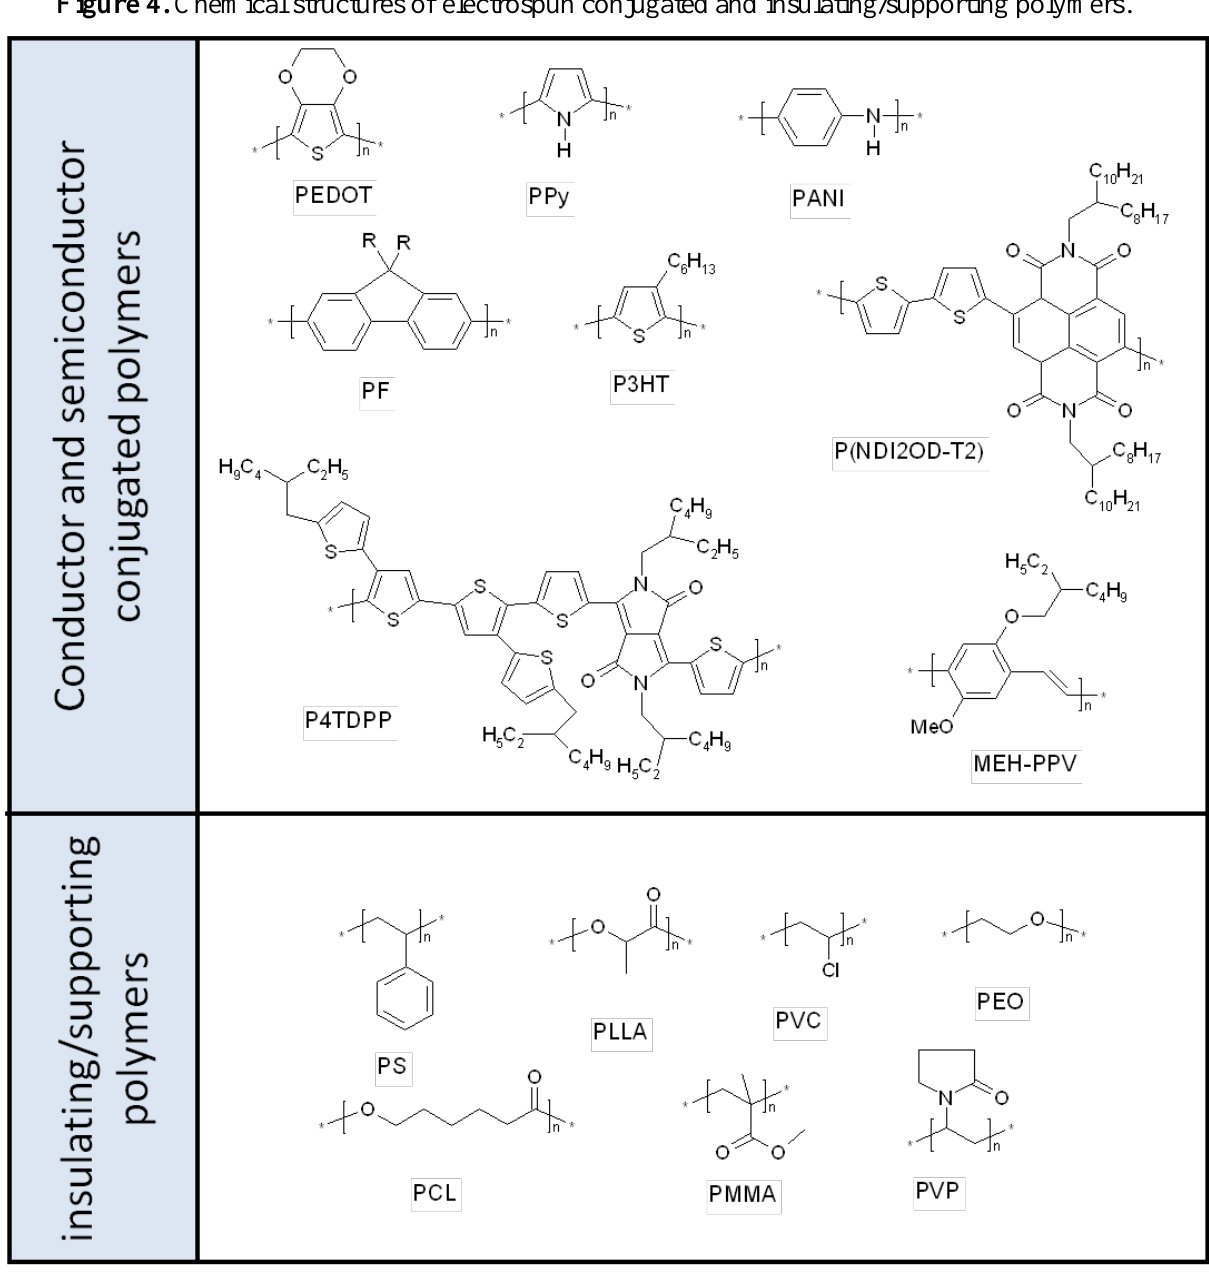
Figure 4. Chemical structures of electrospun conjugated and insulating/supporting